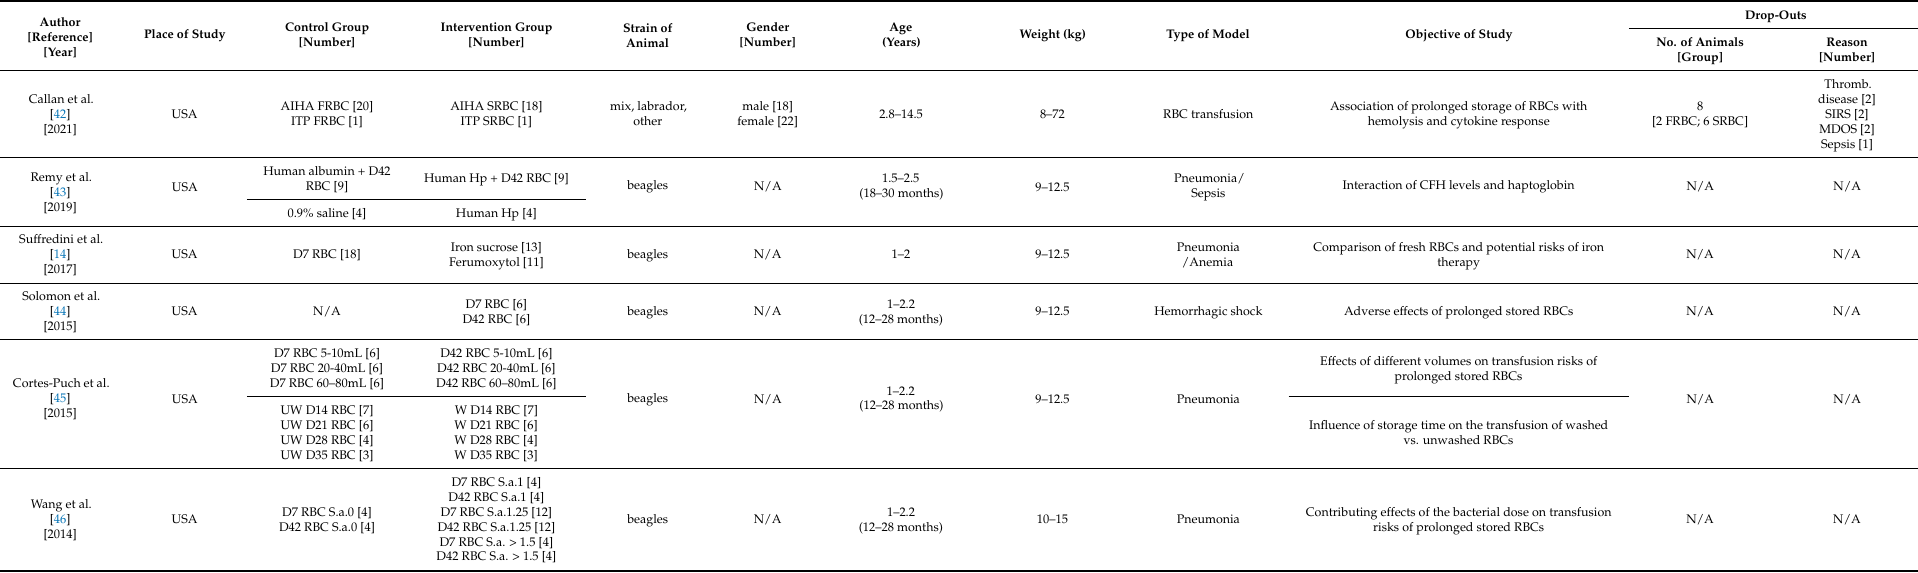
Table 3. Characteristics of included canine studies (group C), sorted by year of